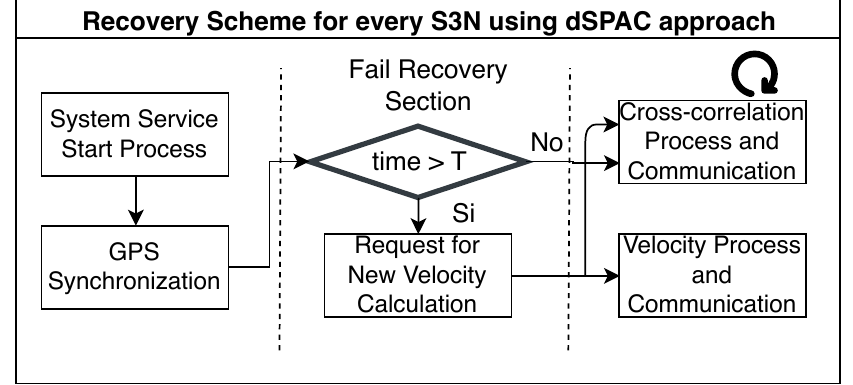
Figure 21. Recovery scheme for system resilience after failures from the sink nodes